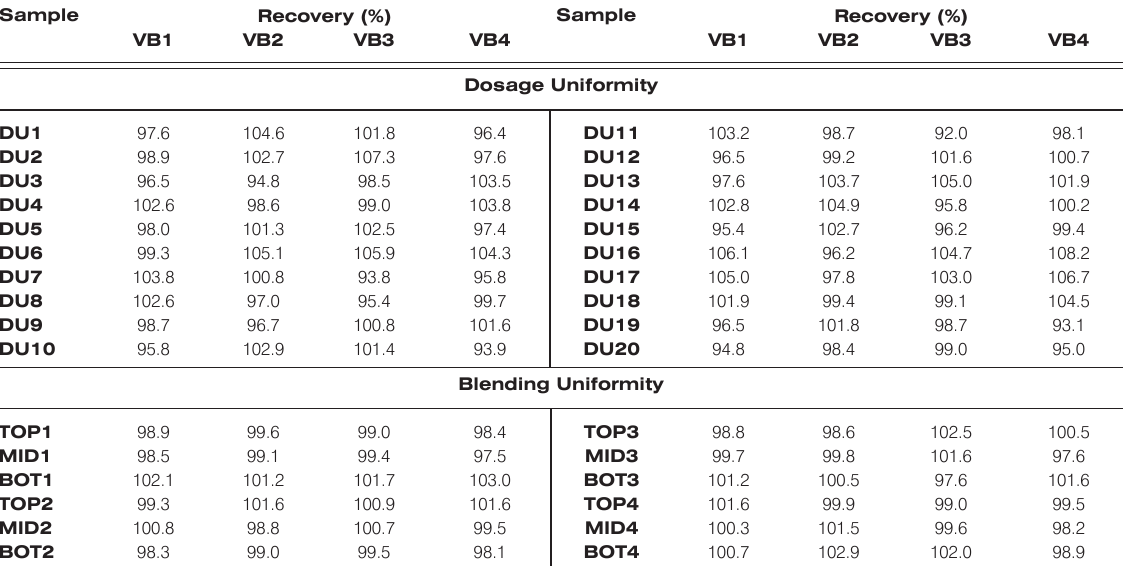
Table 4. Dosage and blending uniformity of the FMT tablets.